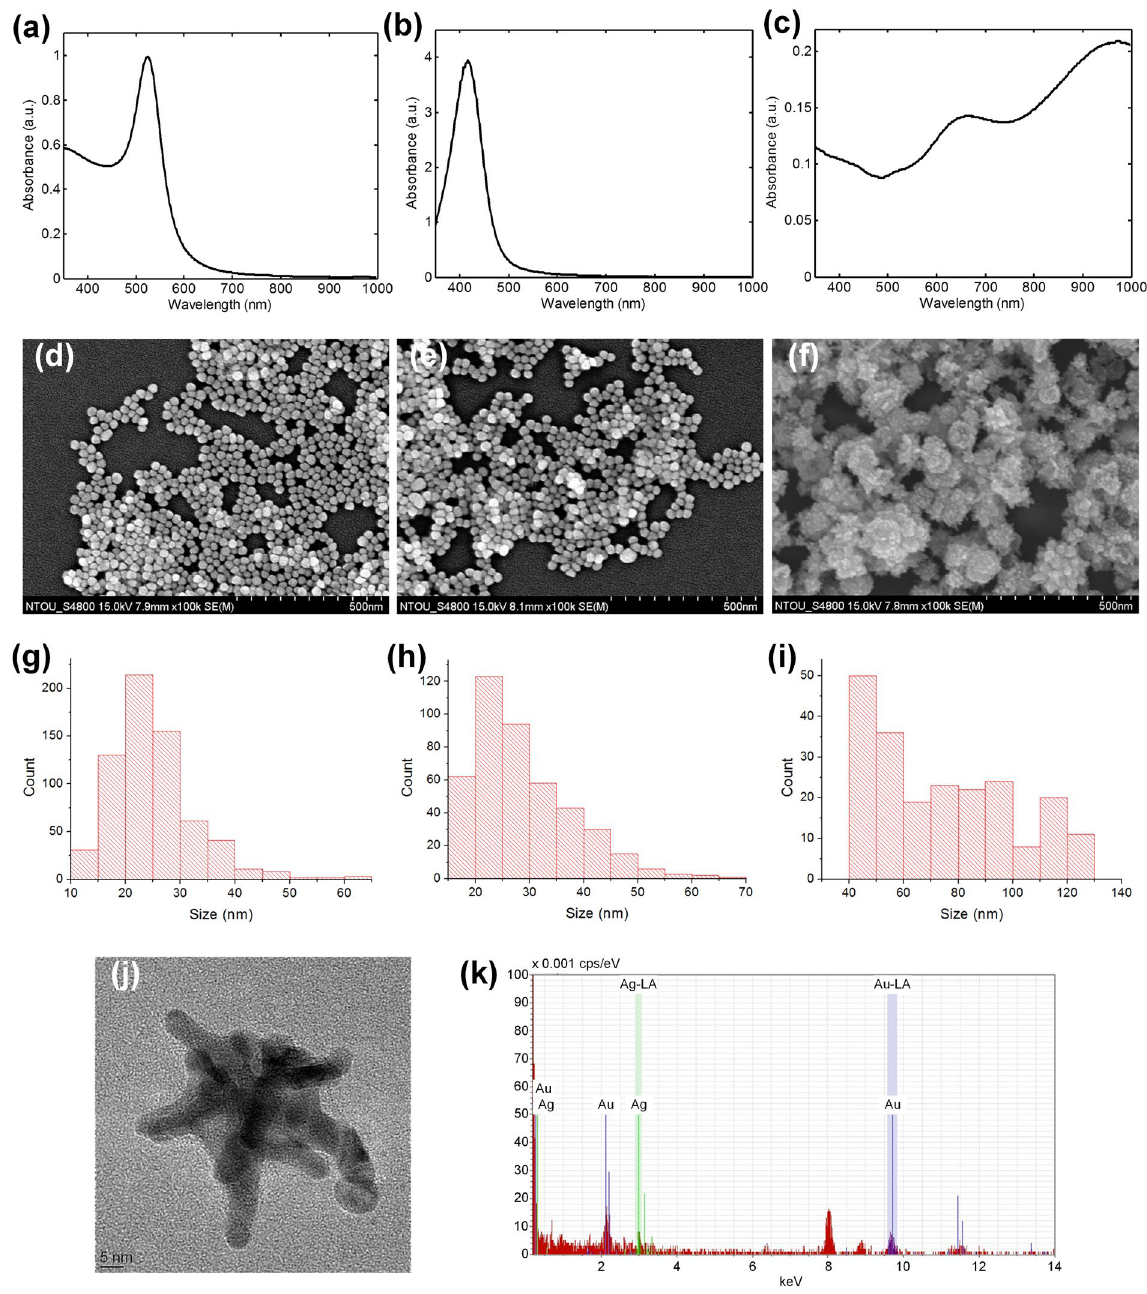
Figure 2. Characteristics of the metal nanoparticles. Absorption spectra of solutions containing ( a ) gold, ( b ) silver, and ( c ) star-shaped gold/silver nanoparticles. SEM images of nanoparticles deposited on the silver film- based substrates for ( d ) gold, ( e ) silver, and ( f ) star-shaped gold/silver nanoparticles. Distributions of particle size, determined from the SEM images, for ( g ) gold, ( h ) silver, and ( i ) star-shaped gold/silver nanoparticles. ( j ) TEM image of a single star-shaped gold/silver nanoparticle having a particle size (tip to tip) of 62 nm. ( k ) Elemental analysis of the star-shaped gold/silver nanoparticles by